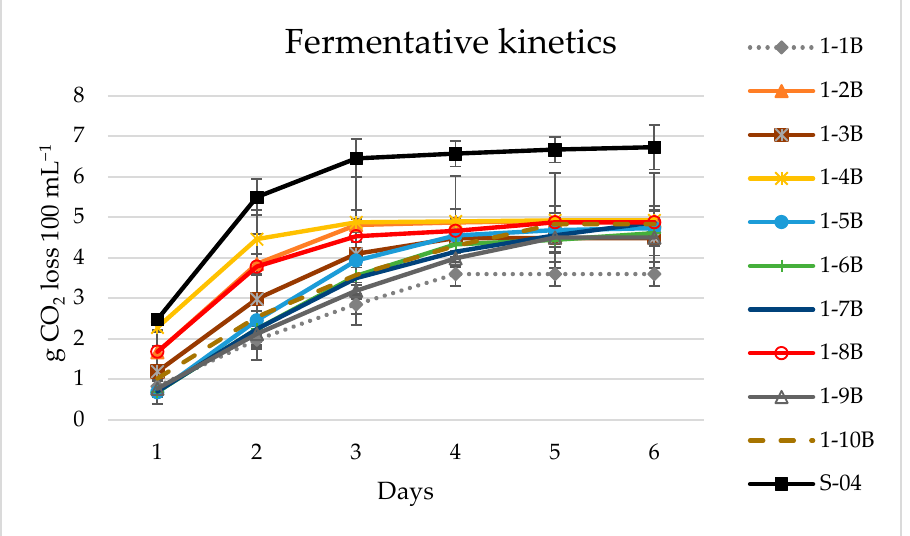
Figure 3. Fermentative kinetic of 10 L. thermotolerans strains fermented in 1 L for sour beer produc- tion.